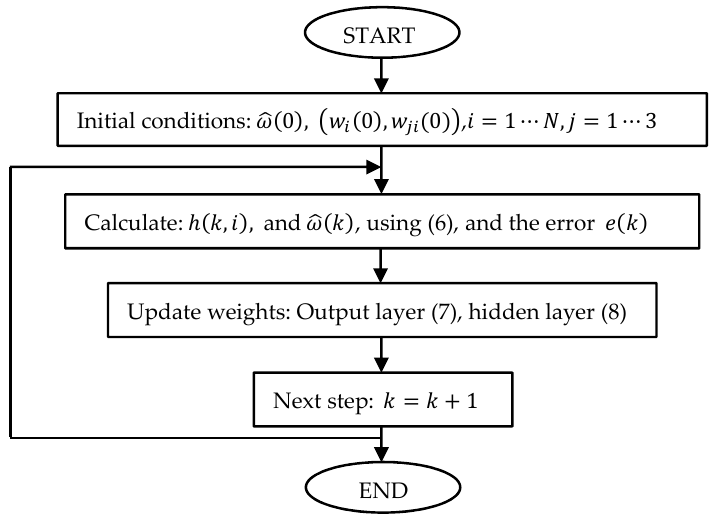
Figure 3. Backpropagation training algorithm.